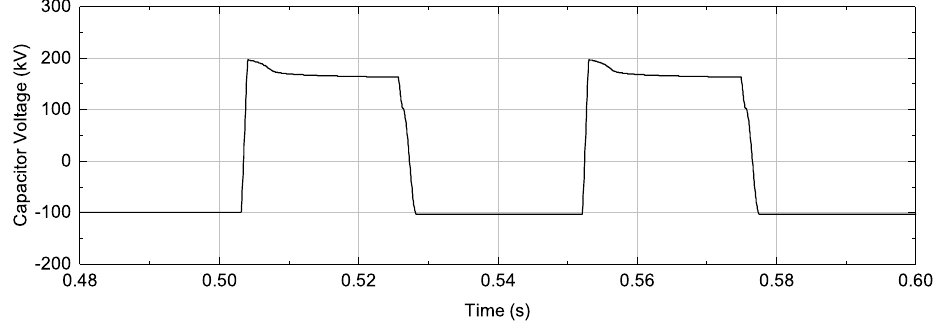
Figure 17. Capacitor voltage in the proposed HCB.